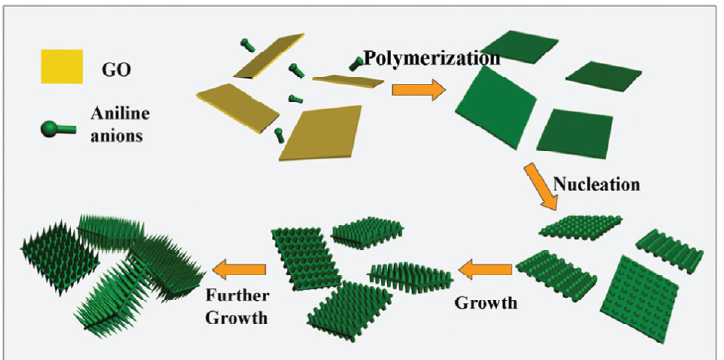
Figure 18. Mechanism of formation of polyaniline (PANI) nanorods on the surface of graphene oxide (GO) (PANI/GO) hierarchical nanocomposites. Reproduced with permission from [253]. Copyright 2013 The Royal Society of